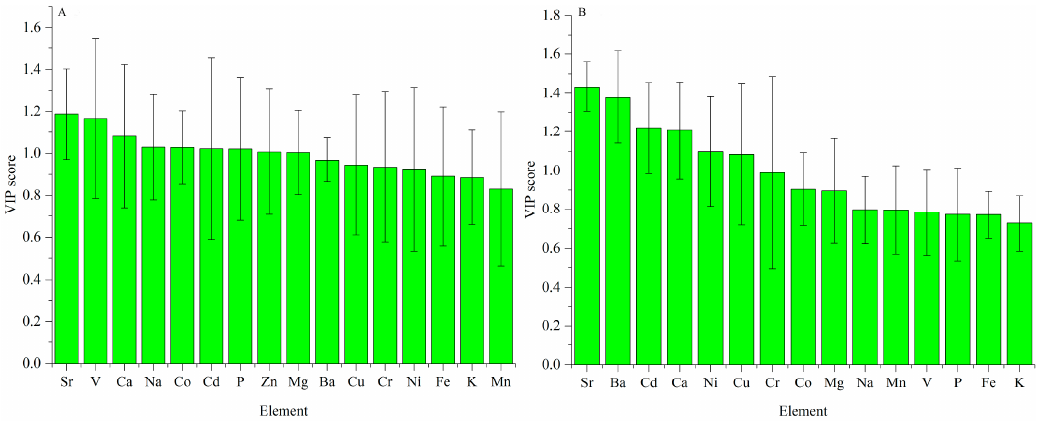
Figure 6. VIP scores of ICP-AES data for regional difference (( A ) Cap; ( B ) stipe).